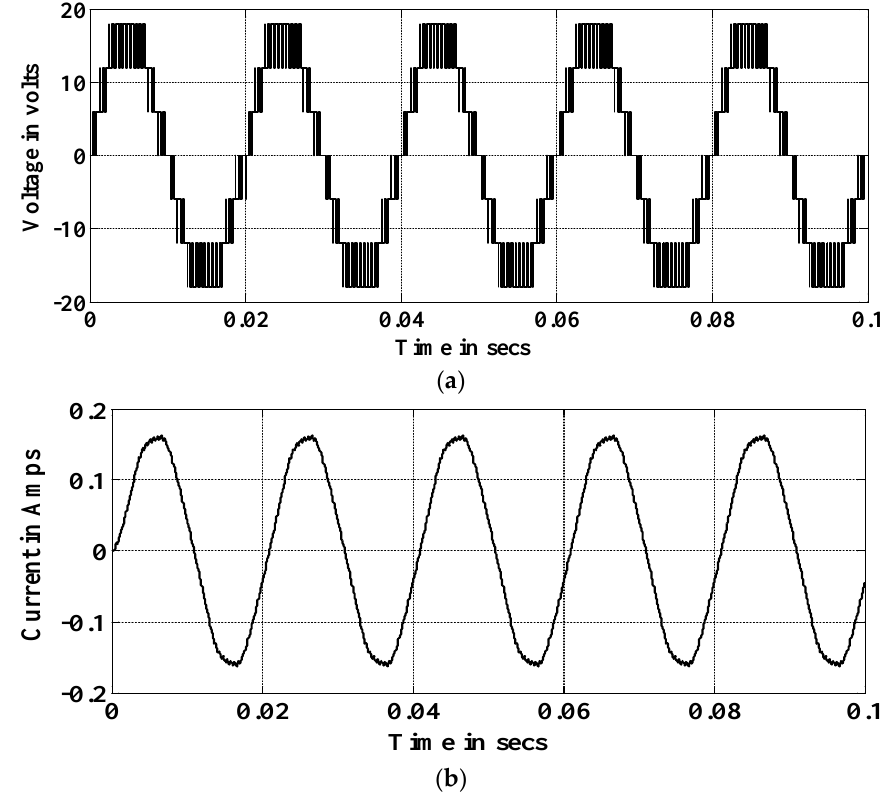
Figure 9. Output waveform for the APODPWM strategy. ( a ) Voltage; ( b ) Current.